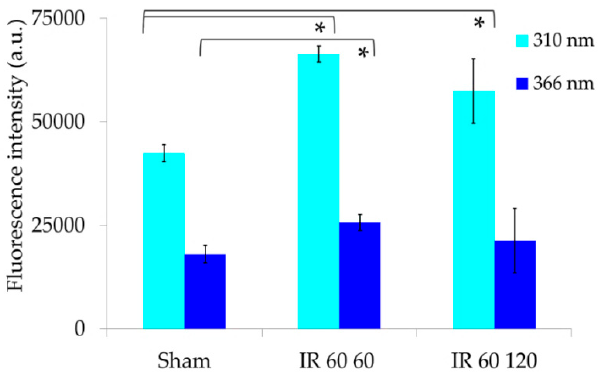
Figure 6. Bar chart representing the integrated values (Means ± S.E.) of the overall emission areas calculated from the AF spectra recorded from serum samples under respective 310 nm and 366 nm excitation, * p ≤ 0.05.